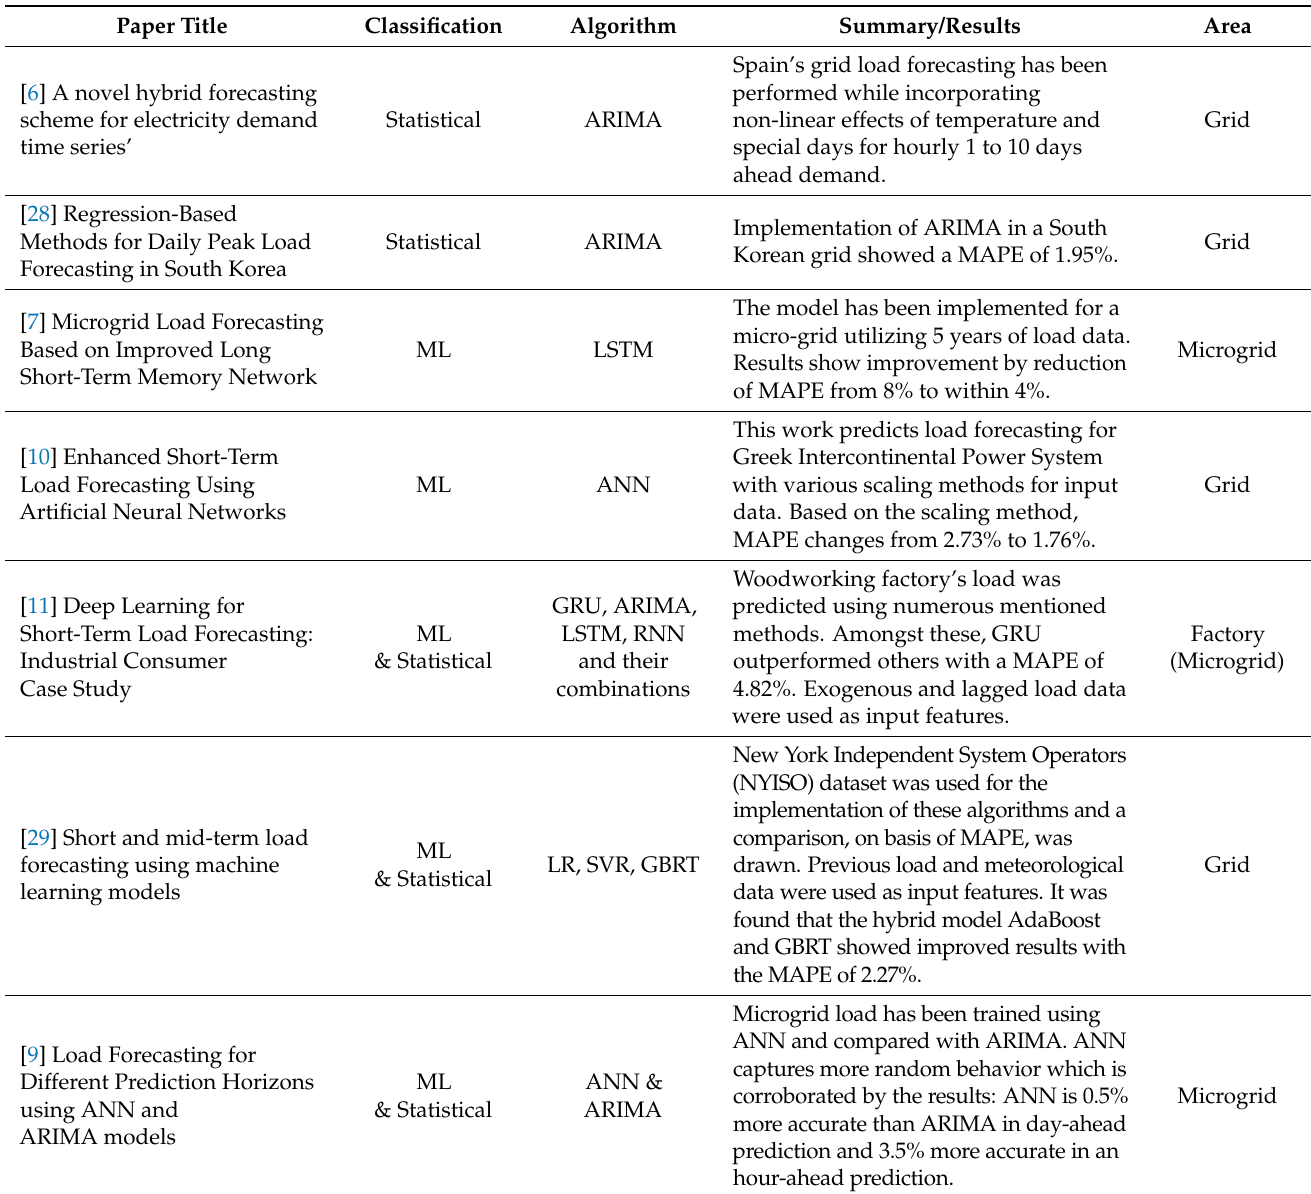
Table 1. STLF algorithms and their implementation for micro-grid and the